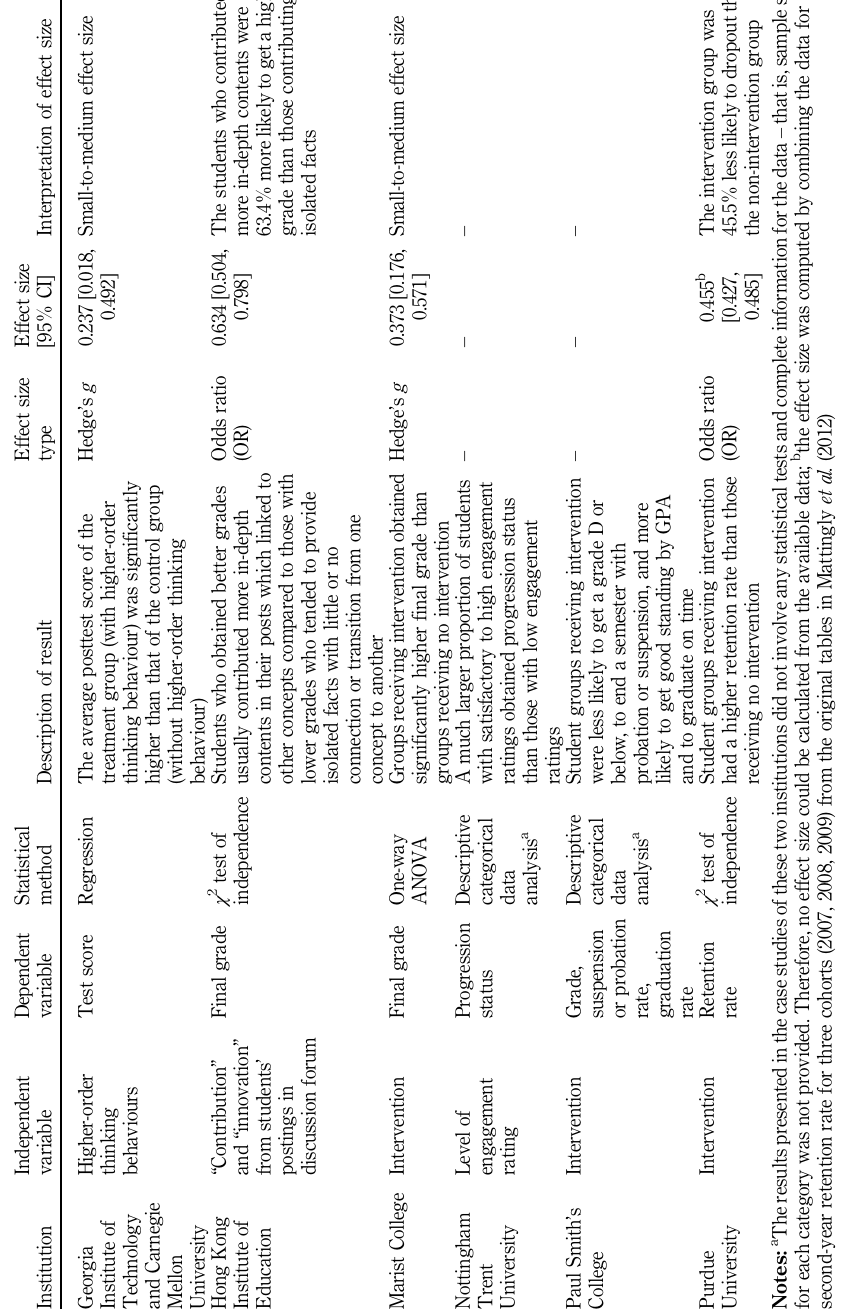
Table VIII. Summary of quantitative analysis results for selected case